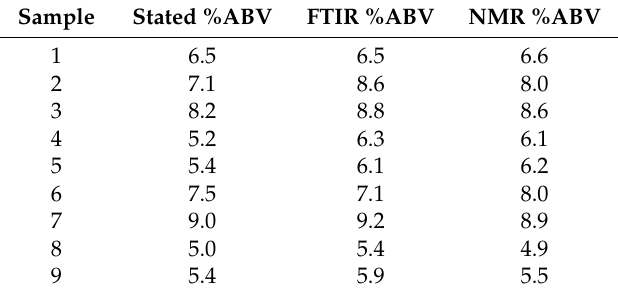
Table 6. Comparison of methods for the determination of ethanol